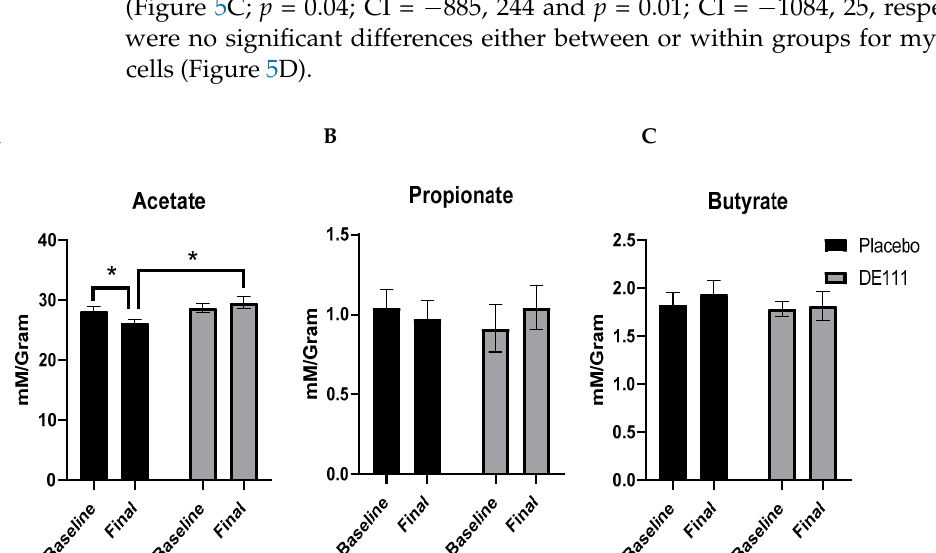
Figure 4. The major microbially-produced short chain fatty acids (SCFA), acetate ( A ), propionate ( B ), and butyrate ( C ) quantified in feces at baseline and post-intervention. Error bars represent ± SEM, *denotes p < 0.05.